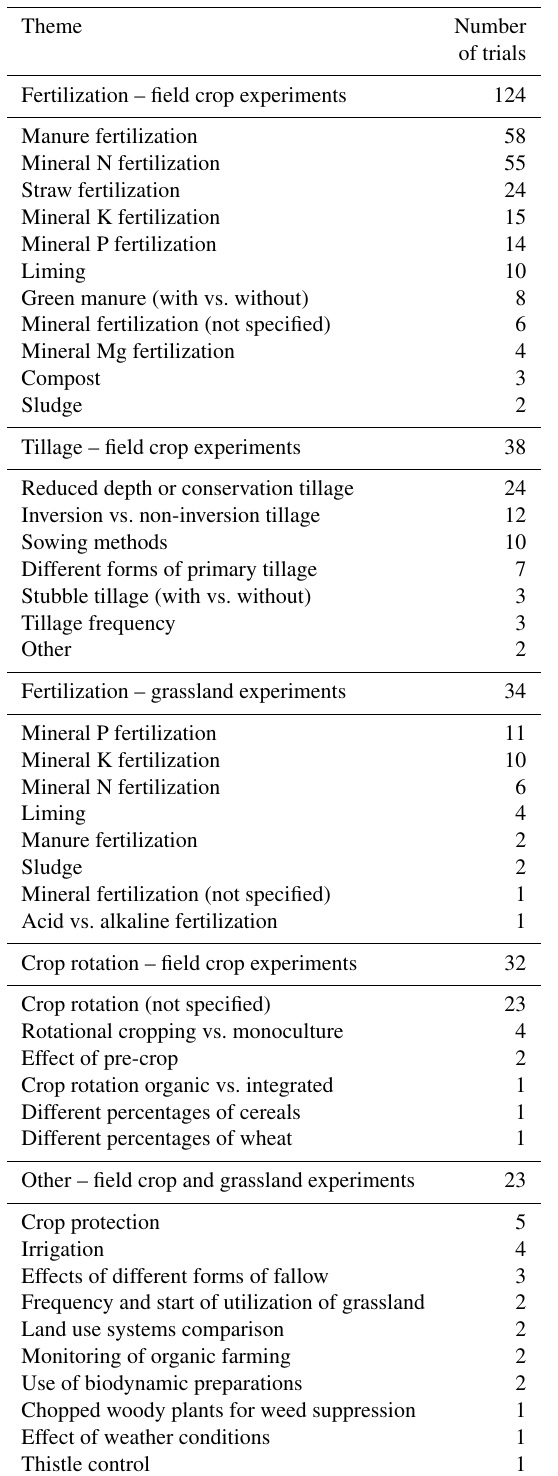
Table 1. Research themes in LTFEs (multiple nominations possible, sorted by